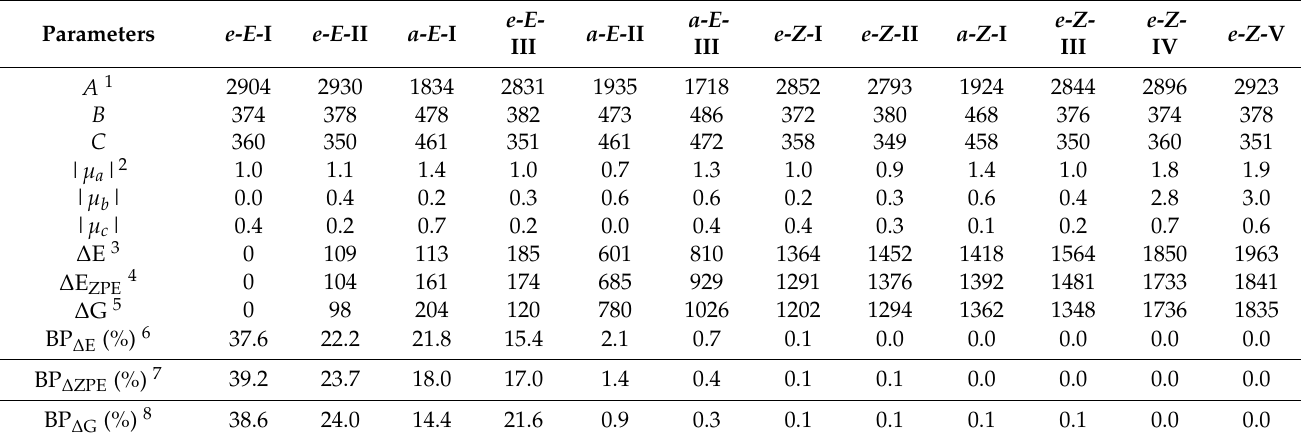
Table 1. Theoretical spectroscopic parameters for low-energy conformers of perillartine computed at the B3LYP-GD3BJ/6-311++G(d,p) level of theory.